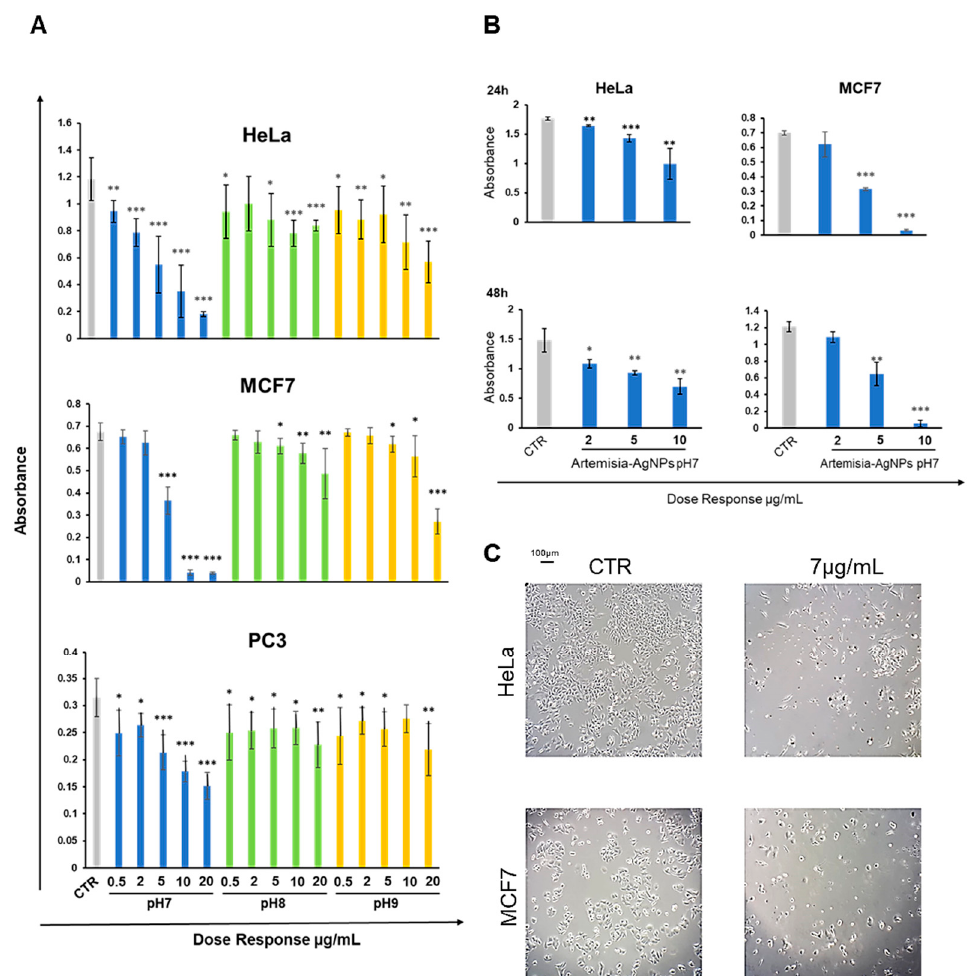
Figure 3 . XTT assay. ( A ) HeLa, MCF-7, and PC3 were treated with increasing doses (0.5–20 µg/mL) of each Artemisia–AgNPs (pH 7, pH 8, and pH 9). An XTT assay was performed to evaluate cell viability. ( B ) XTT assay of Artemisia–AgNPs pH7 on HeLa and MCF-7. HeLa and MCF-7 were cultured with 2, 5, and 10 µg/mL of Artemisia–AgNPs pH 7. Cell viability was evaluated using XTT assay. ( C ) Microscope images. HeLa and MCF-7 treated for 24 h with 7 µg/mL of Artemisia–AgNPs pH 7. Data were analyzed using Student’s t test, * = p value < 0.05, ** = p value < 0.01, *** = p value < 0.001.